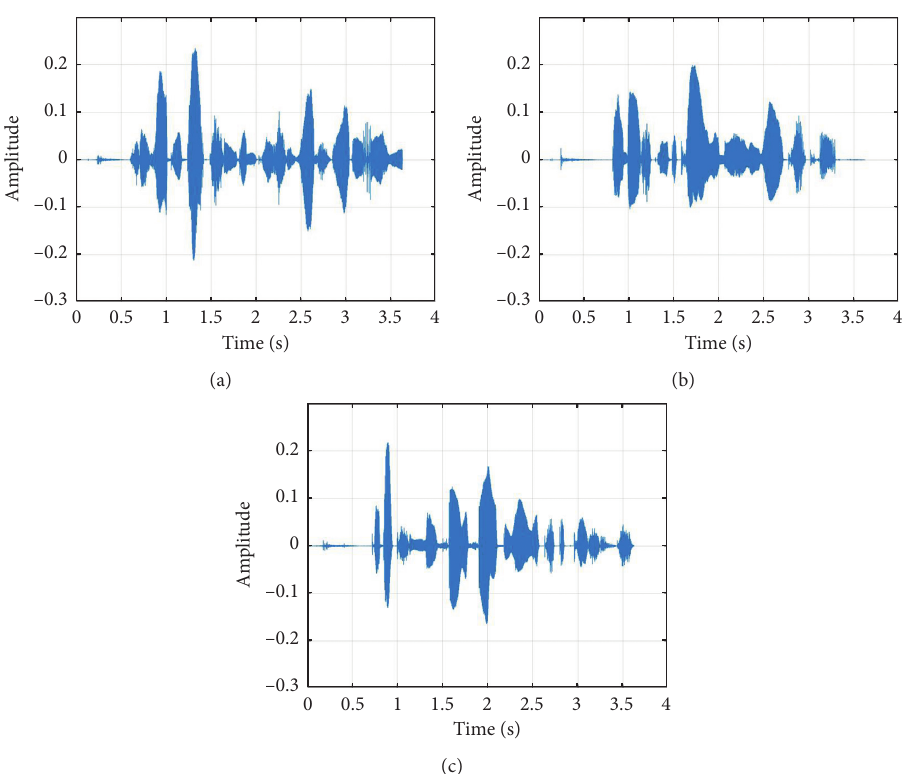
Figure 11: Time-domain waveforms of source signals (three speech signals): (a) SA1 speech signal; (b) SA2 speech signal; (c) SI943 speech signal.